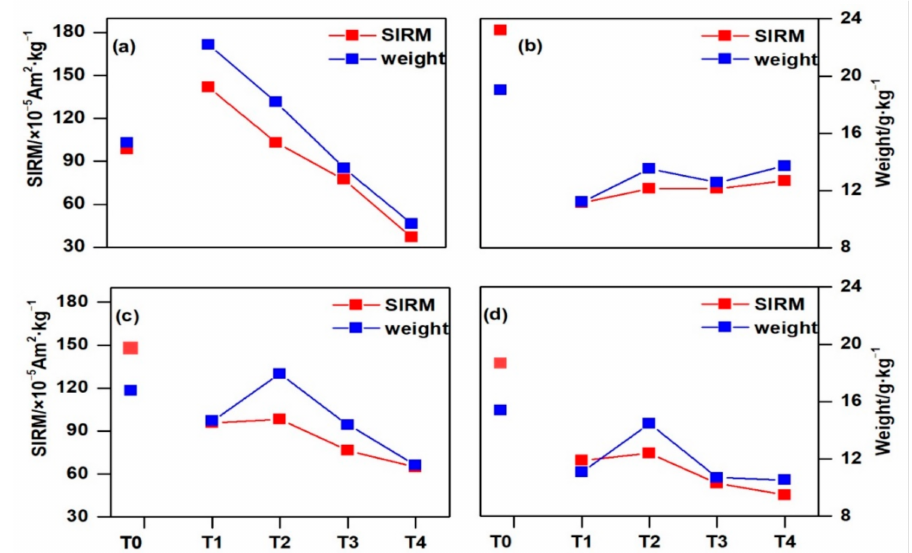
Figure 3. Variation in the SIRM and weight of PM deposited on the needles at different sampling